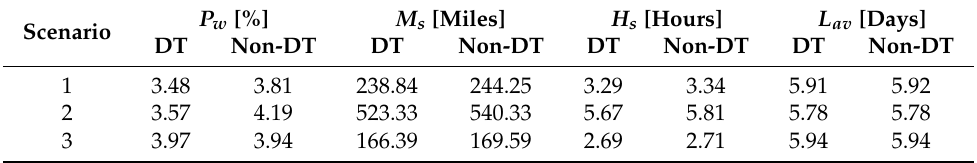
Table 5. The mean values of the data presented in Figure 8 where DT represents digitalised.